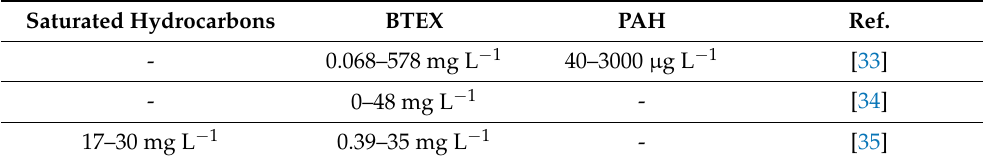
Table 1. Typical ranges of saturated and aromatic hydrocarbons in produced water